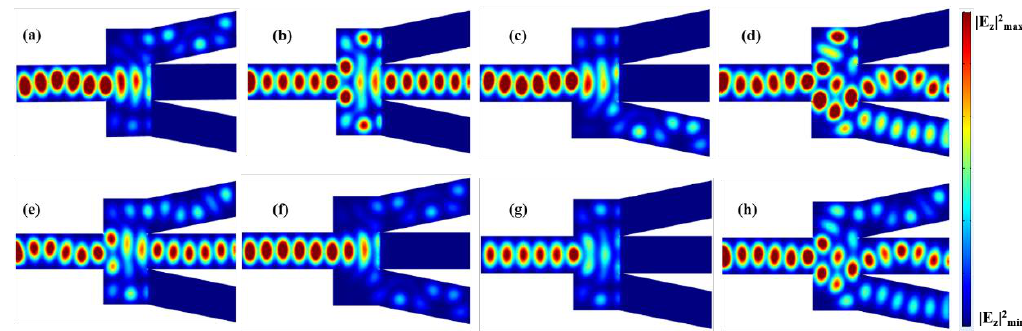
Figure 5. Distributions of | E z | 2 in the x - y plane of the single-input three-output switch, in the output logical states of ( a ) “100”; ( b ) “010”; ( c ) “010”; ( d ) “011”; ( e ) “110”; ( f ) “101”; ( g ) “000” and ( f ) “111”.